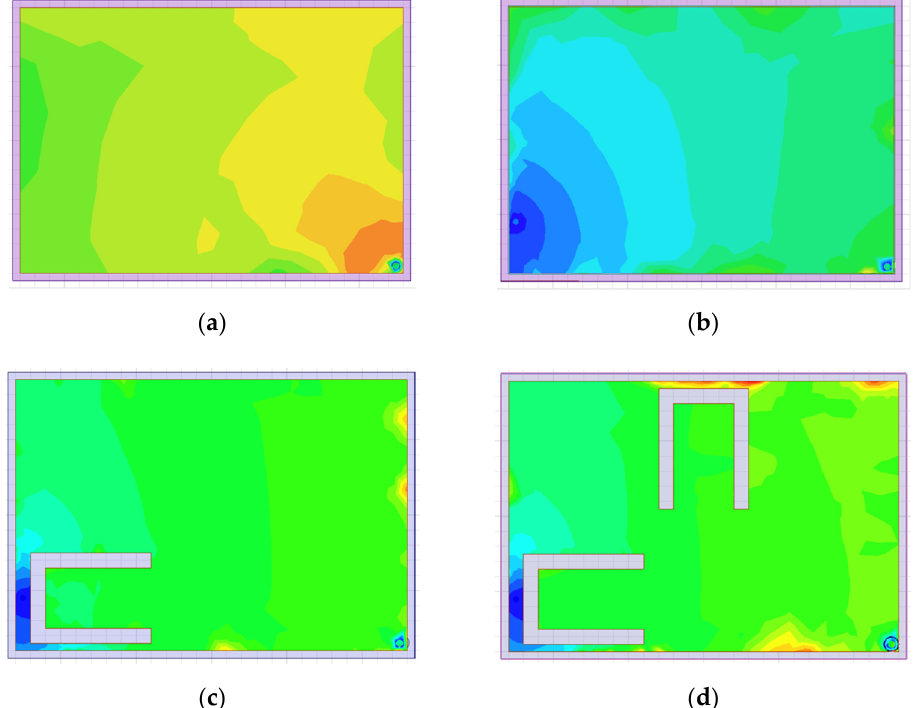
Figure 16. Electric field distribution of the modified antenna at 402.5 MHz without structure modifications ( a ), after inserting the sorting pin ( b ), after inserting the first U-slot ( c ), and after inserting the second U-slot ( d ).